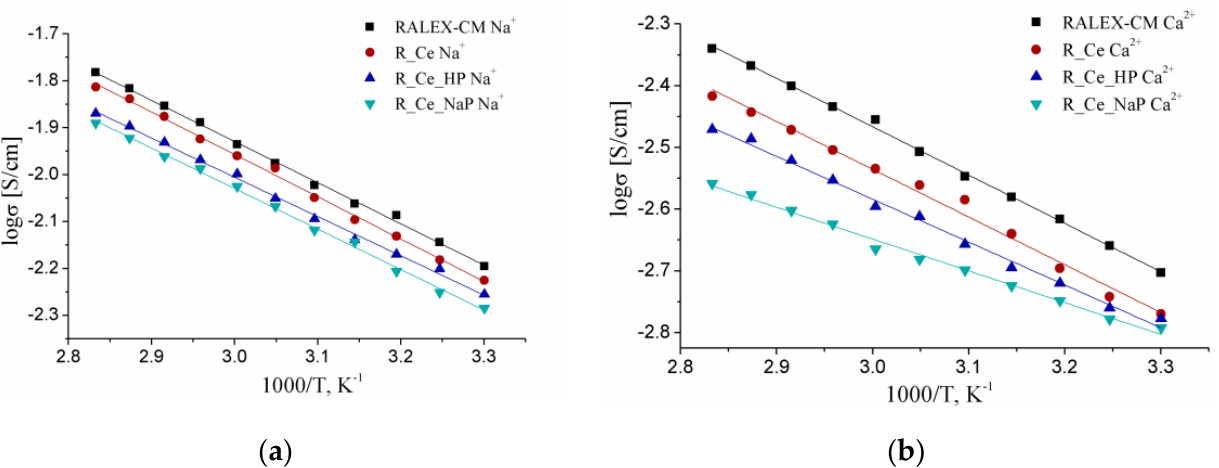
Figure 3. Temperature dependences of conductivity of the modified membranes in the Na + - ( a ) and Ca 2+ - ( b ) forms.